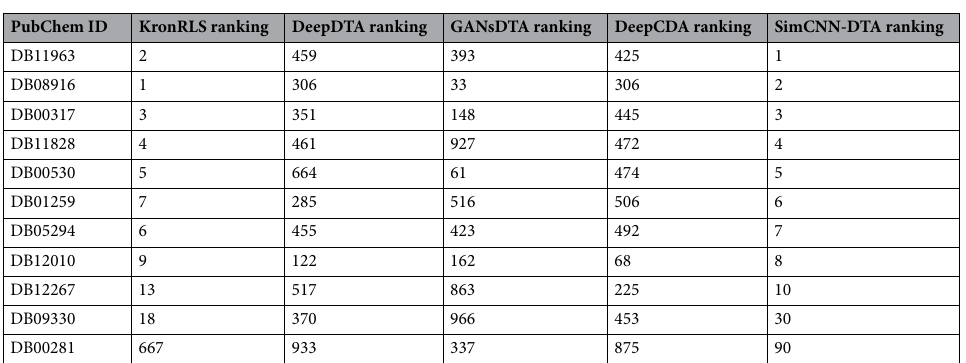
Table 4. Compound ranking based on the predicted affinities of SimCNN-DTA when the target is EGFR.